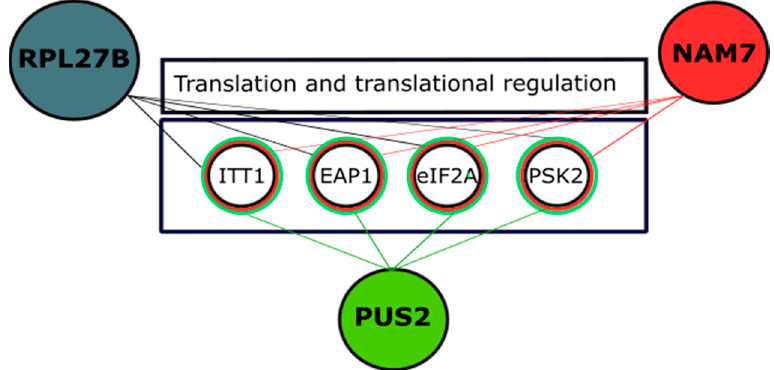
Figure 8. Over-expression of NAM7 , PUS2 , and RPL27B compensate for the sensitivity of ITT1 ∆ , EAP1 ∆ , eIF2A ∆ , and PSK2 ∆ to 10 mM LiC. EAP1 is known to be involved in negative regulation of translation via DHH1 (RNA helicase) and PSK2 is involved in translation regulation of mRNAs with uORFs. eIF2A and ITT1 participate in translation initiation and termination steps, respectively.